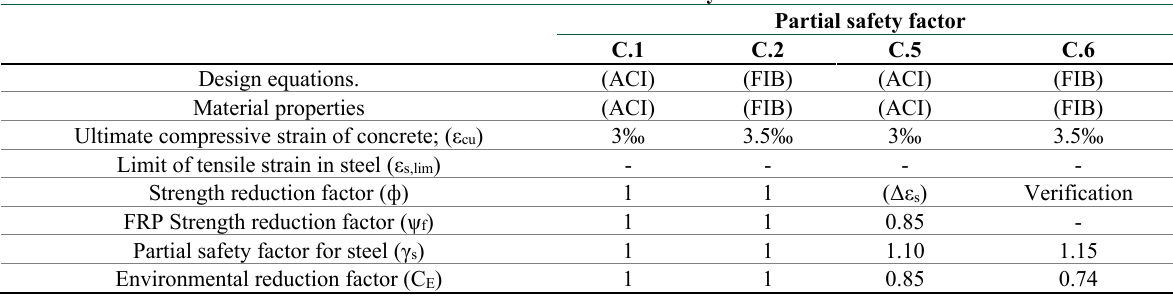
Table 3. Criteria defined for analysis. Parameters established for the analysis criteria